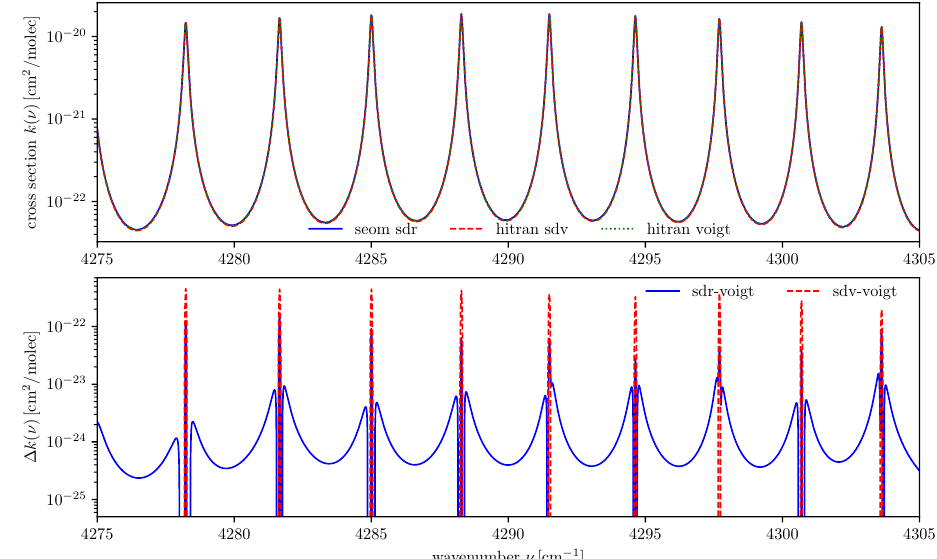
Figure A5. Absorption cross-sections of CO at reference pressure and temperature for SEOM and two variants of the HITRAN2016 line data (upper panel). In the lower panel the classical HITRAN case (Voigt) is subtracted from the SDR and SDV cross-sections using SEOM and HITRAN, respectively. The SDR-Voigt difference (blue) is moderate in the line center and wings and small in the transition region. In contrast, the SDV-Voigt difference (red) is large only in the line center and drops sharply in the line wings.